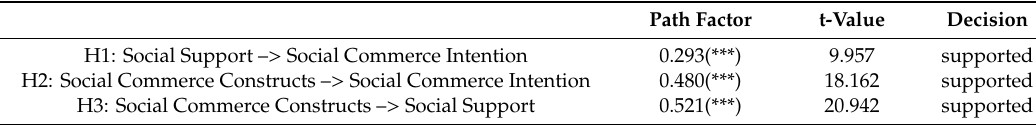
Table 5. Verification of research